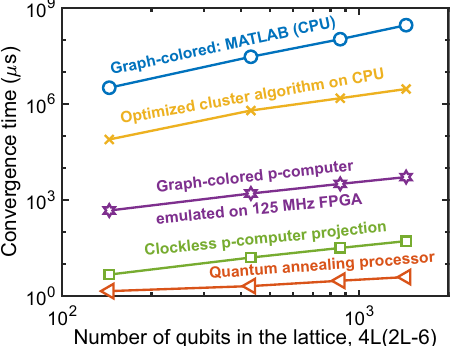
Fig. 5 Convergence time for problems of increasing size using different hardware implementations. The convergence time is extracted using the protocol described in Data fi tting and convergence criterion subsection of Method section for the problem de fi ned in Fig. 2. The data for optimized CPU (yellow cross) (mean of counterclockwise and clockwise wound initial states) and quantum annealing processor (red triangles) (for counter clockwise wound initial state only) are extracted from the information provided in King et al. 36 (Fig. 4 and supplementary Fig. 13 therein), while the results for graph-colored MATLAB (blue circles) (simulated on CPU), digital (purple star) and clockless p-computers (green squares) are obtained in this paper as described in the text. This CPU simulation of graph colored algorithm is performed with a vectorized MATLAB code running on Intel(R) Core(TM) i7-10750H CPU (2.60 GHz, 16 GB RAM, Windows 11 Home operating system and single thread simulation are used). As mentioned in the caption of Fig. 3, only the leftmost data point on the p-computer (FPGA: fi eld programmable gate array) curve is obtained from actual FPGA emulation. The rest of the points on the curve are projections based on the simulations on the CPU. The slope of the p-computer curve is clearly different (and smaller) from the graph-colored MATLAB (CPU) and optimized four qubit continuous time path integral Monte Carlo algorithm (simulated on CPU) curves (the exact slopes found using curve fi tting are listed in Supplementary Note